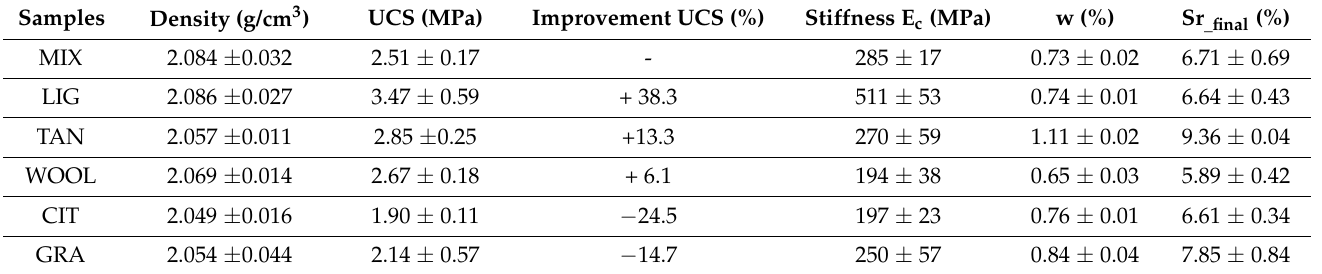
Table 2. Results of the unconfined compression test, rate of UCS improvement, chord modulus E c , the water content in the specimens (w) and the final saturation degree in the samples. The data are reported as mean values ± their standard deviations.